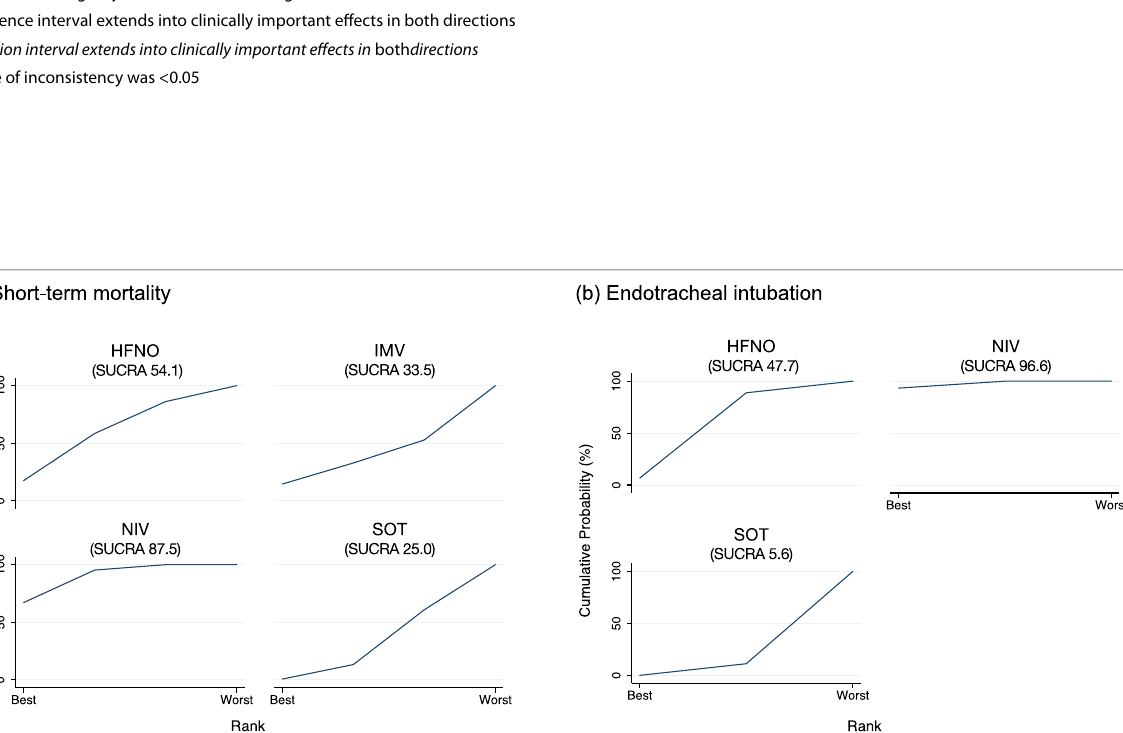
Confidence interval extends into clinically important effects in both directions b Prediction interval extends into clinically important effects in both directions c